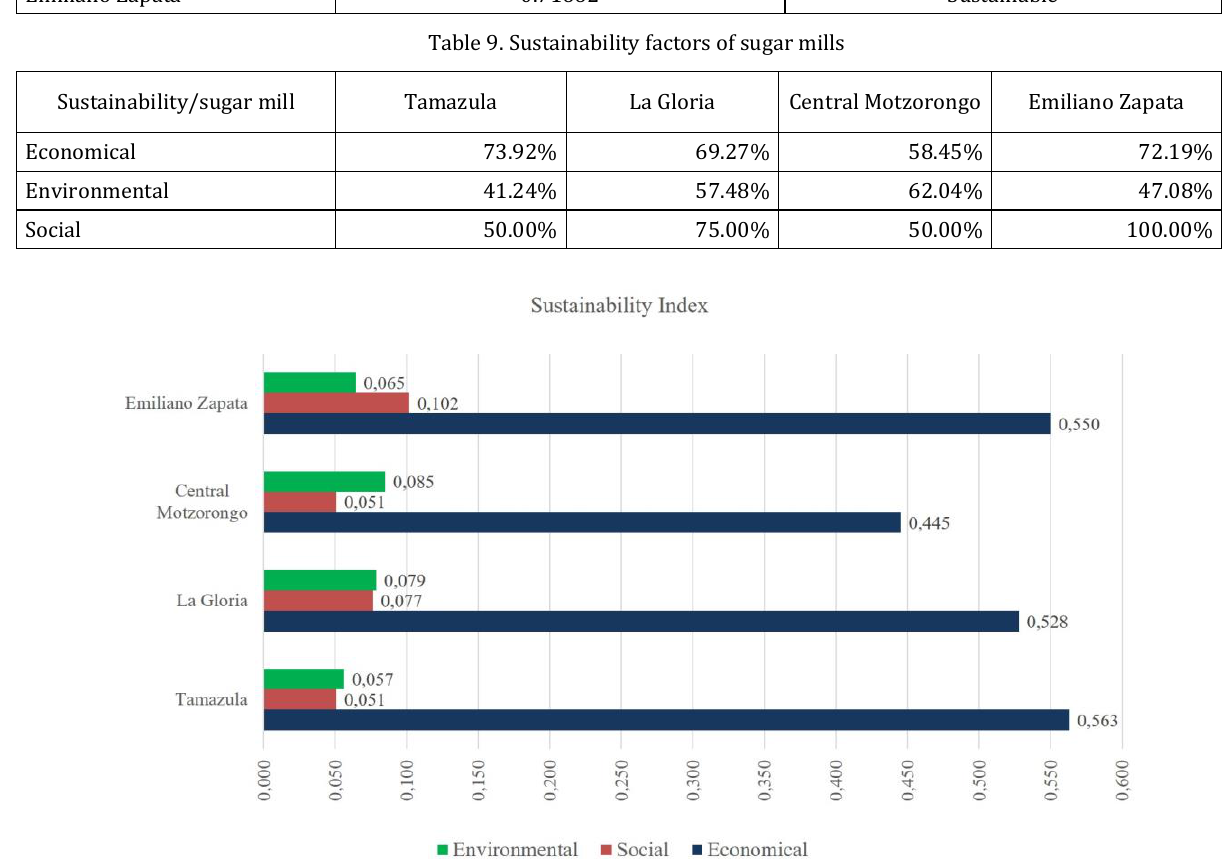
Table 9. Sustainability factors of sugar mills